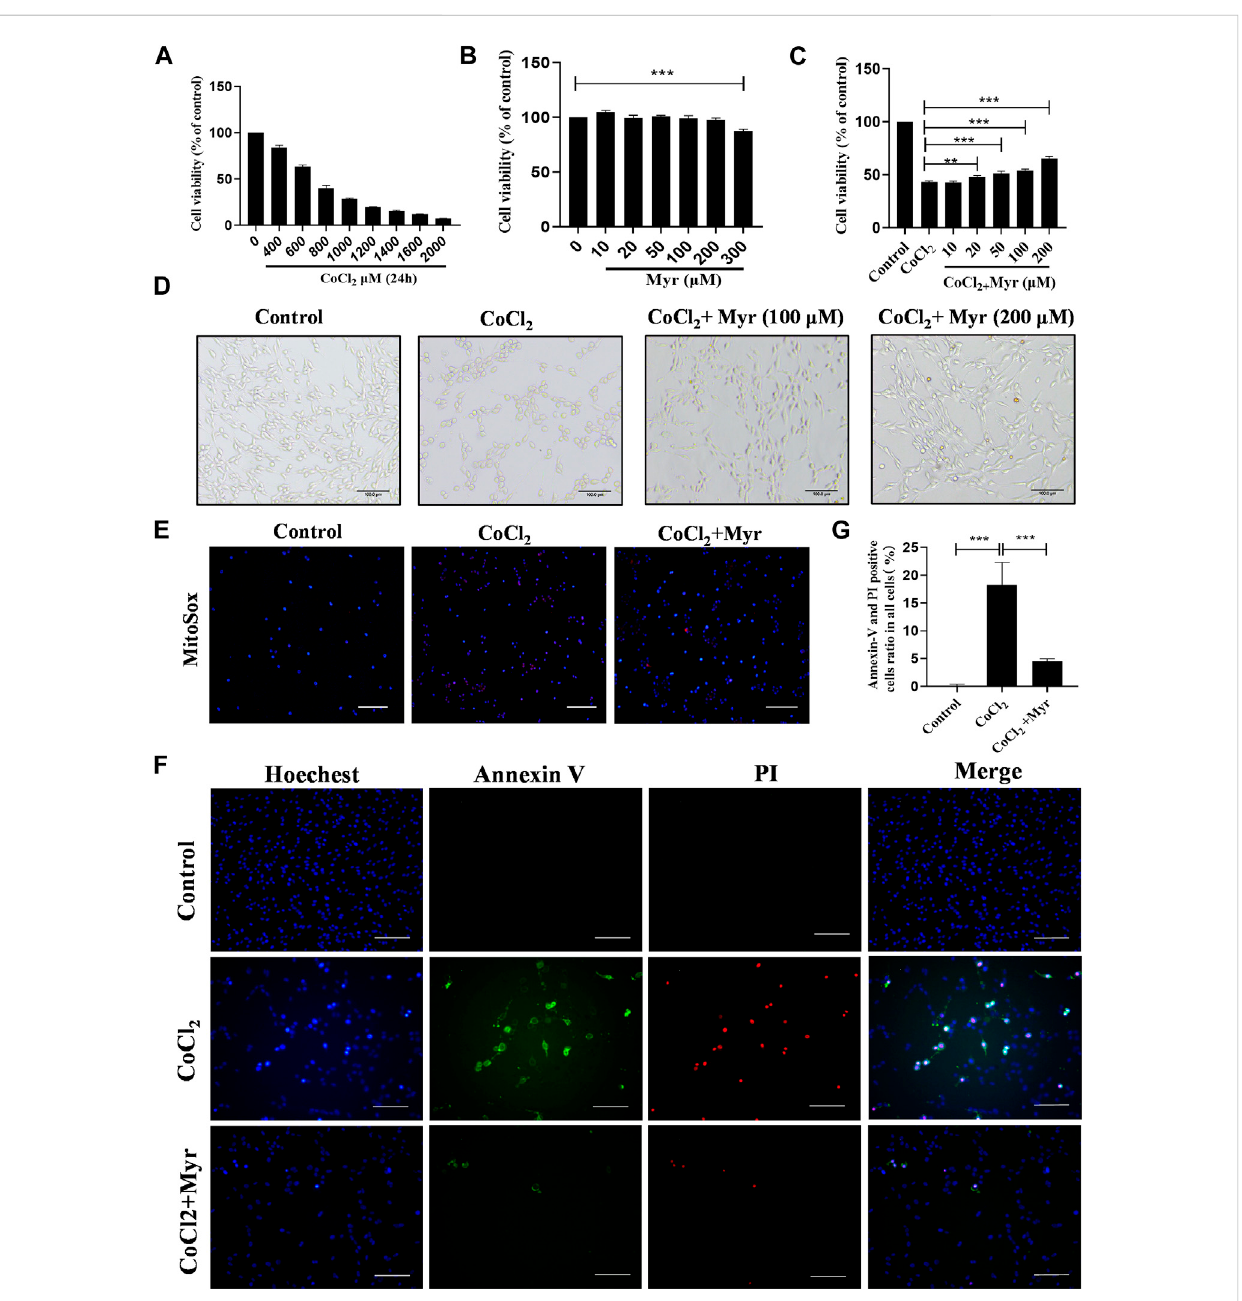
FIGURE 6 Myricetin alleviated CoCl 2 -induced injury and mitochondrial ROS production in PC12 cells. (A) The cell viability of PC12 treated with different dose CoCl 2 for 24 h using CCK-8 ( n = 4 per group). (B) The safe dose ranges of myricetin to maintain cell viability was determined by CCK-8 assay ( n = 4 per group). (C) Thedose-dependenteffectofmyricetinonPC12cellviabilityafterCoCl 2 injury( n =4pergroup). (D) Theeffectsofmyricetinatdifferentdoses on morphology of PC12 cells after CoCl 2 injury. (E) The generation of Mitochondrial ROS in PC12 was detected by MitoSOX (red) and DAPI (blue) staining. (F) The images of Annexin V FITC (green) and PI (red) co-staining to detect apoptosis. The nuclei were labeled with Hoechest (blue). (G) QuantitativeanalysisofAnnexinVandPIpositivecells( n =4pergroup).Thedataarepresentedasmean±SD.** p < 0.01,*** p < 0.001.Scalebar:200 μ m in (E) ; 100 μ m in (F)